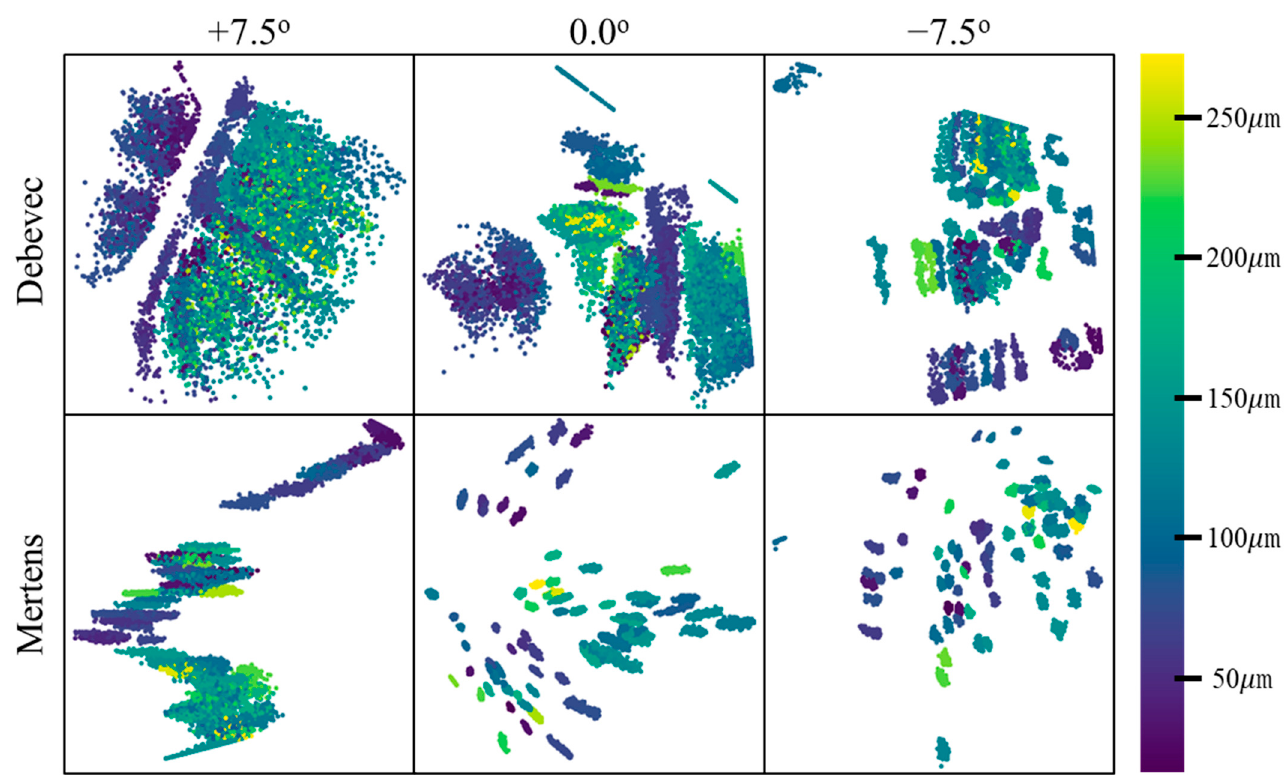
Figure 8. Dimensionality reduction results.